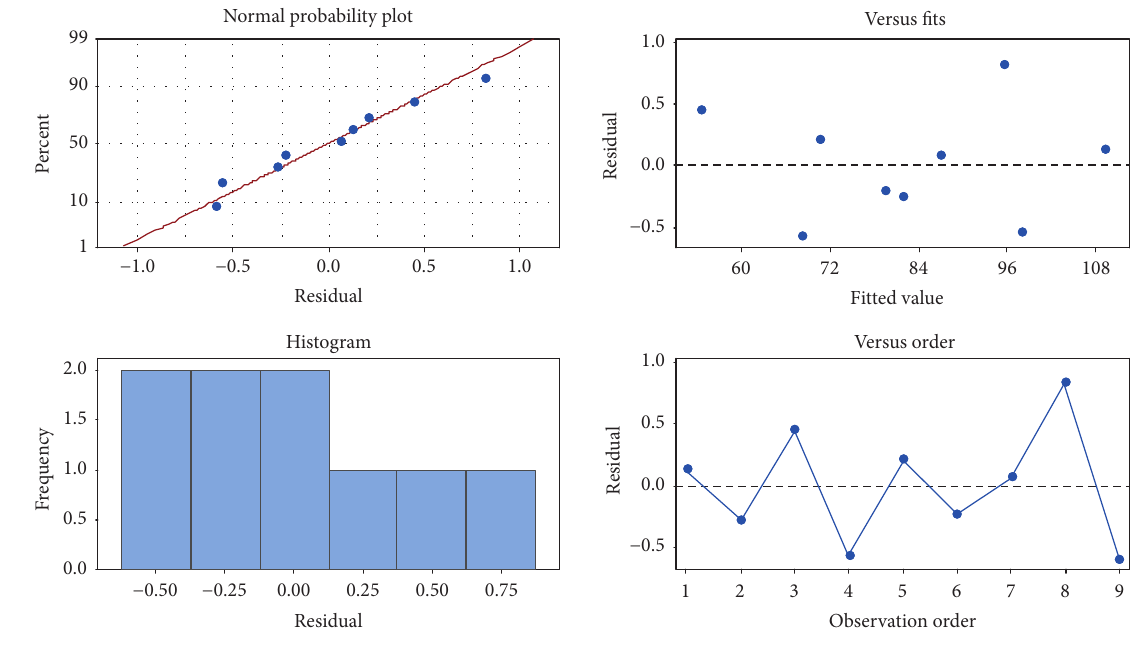
Figure 4: Residual plots for tensile test. Table 5: Impact strength of TIG-welded AA8006